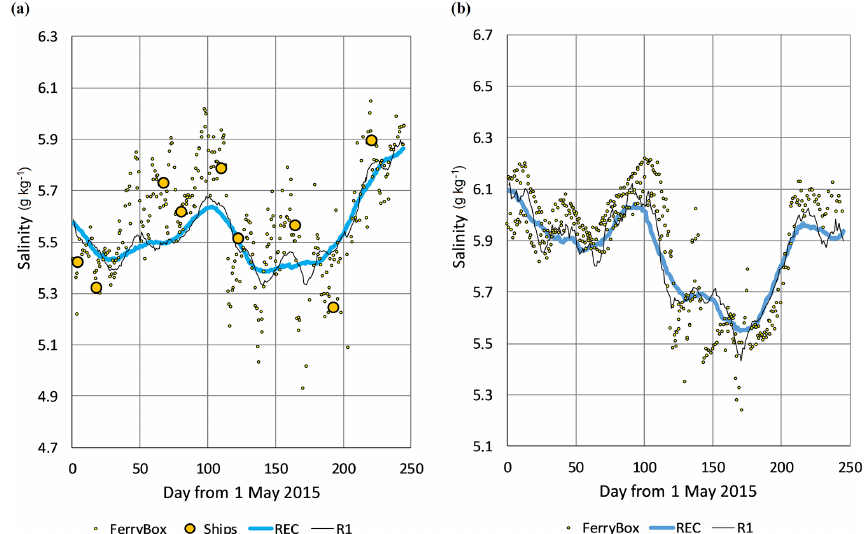
Figure 4. Salinity time series at locations (a) 59.8383 ◦ N, 24.8383 ◦ E (HELCOM station F3) and (b) 59.794 ◦ N, 24.822 ◦ E, during the study period. Shown by dots are the observations from FerryBox and from ship monitoring. Reconstructed time series, made using the time- dependent method, are given by solid lines: REC – basic option with 30d interval, all observations in window were kept as they are; R1 – the same as previous but with time interval